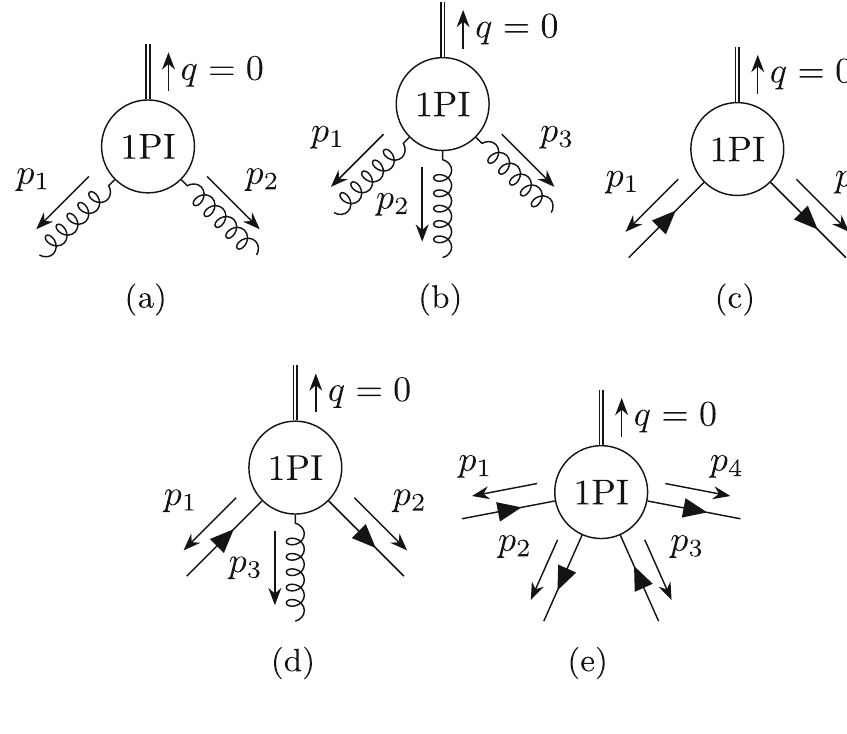
mixed actions without too much effort. All necessary graphs are obtained using QGRAF [52,53]. The operator inser- tions are realised by formally introducing additional non- propagating fields ϕ i called “anchor” and adding to the Lagrangian. These anchors correspond to the double lines in Fig. 1. For all n -point functions with a single operator insertion, except single flavour 4-fermion operators, setting options =